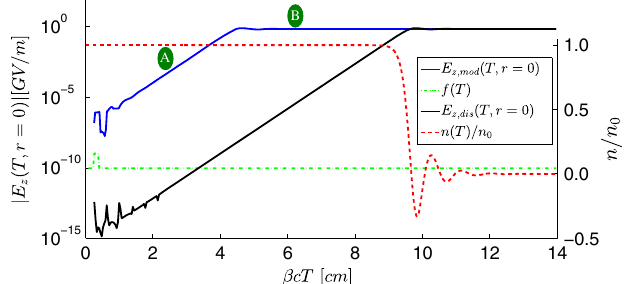
FIG. 2. Wake comparison between the modulated trigger bunch (blue solid curve) with the single electron trigger bunch (black solid curve). The green dotted curve shows the location of the trigger bunch and the dashed curve shows the PID dynamics. The ellipses A and B show the locations of the accelerated second trailing train bunch that will be considered in the acceleration regimes section (V).